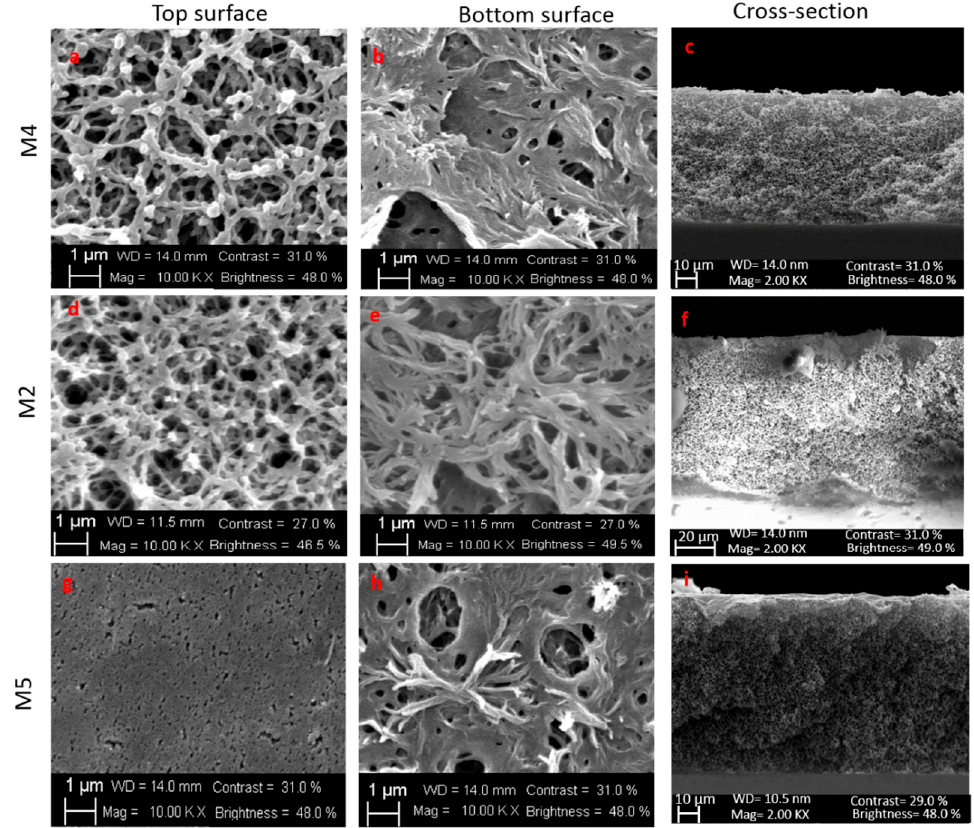
Figure 5. SEM images: top surface and bottom surface of membranes M4, M2, and M5.